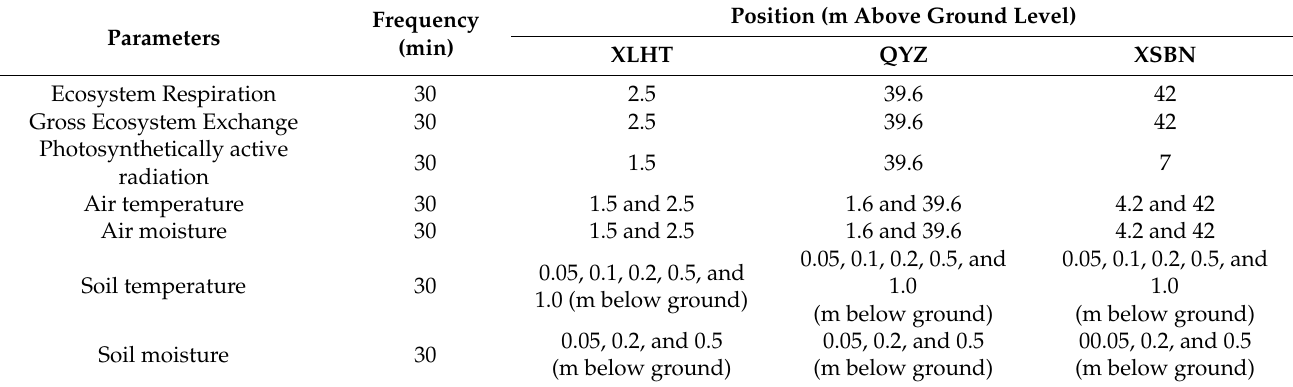
Table 2. Instrument layout and monitoring